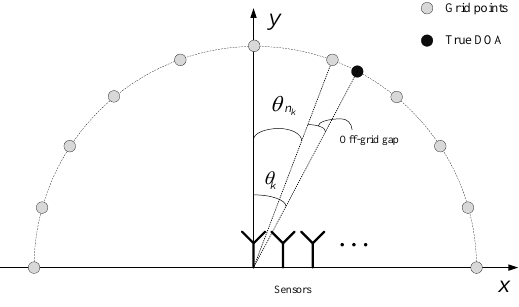
Figure 1. The sparse signal model of off-grid